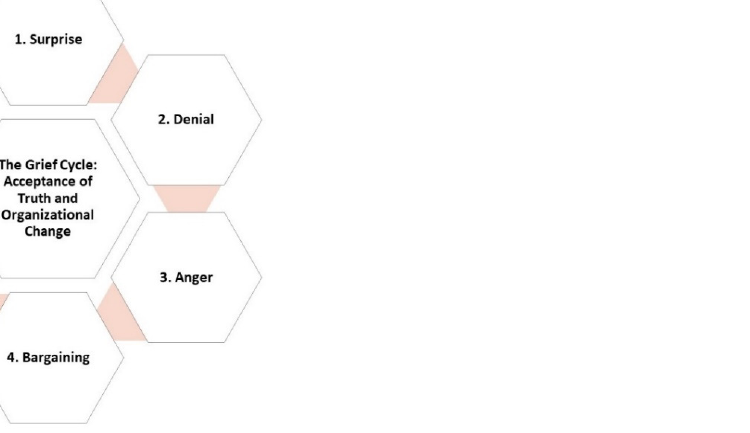
Figure 2. Six phases of grief leading to acceptance of the truth and buy-in to organizational change. Simplified and recreated from Stokke (2014).